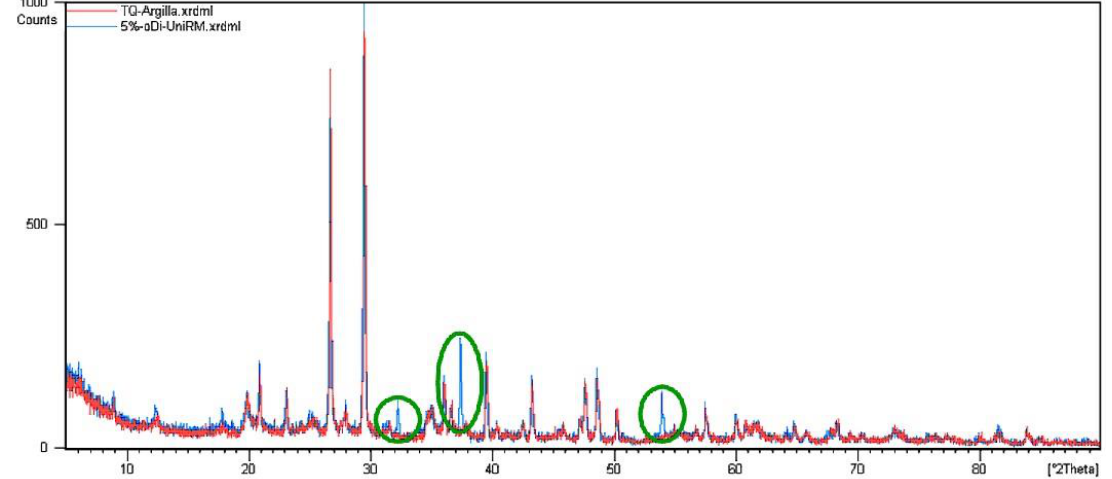
Figure 5. TQ3 diffractogram at day 0 (blue) overlaid on that of TQ0 (red).